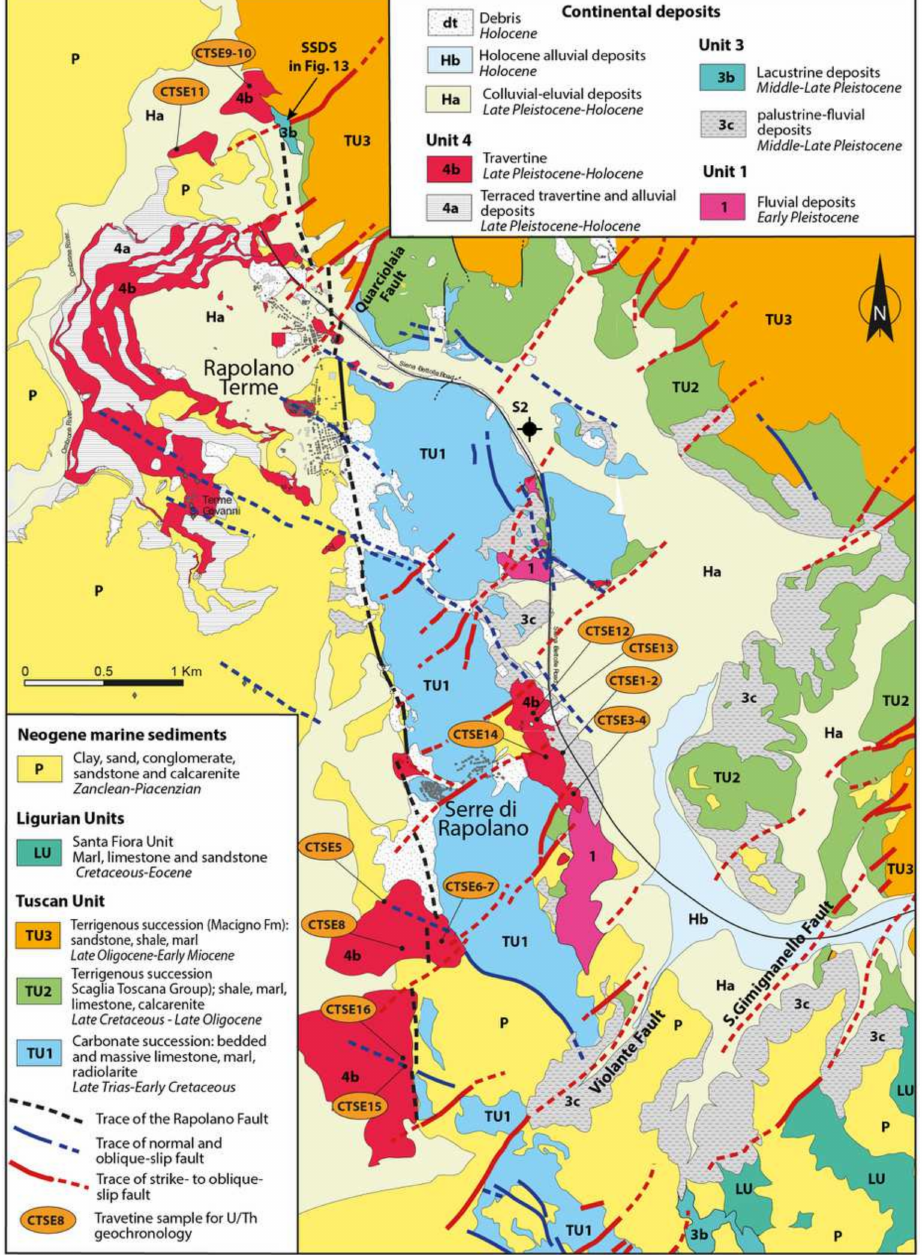
Figure 5. Geological map of the Sentino Basin (after [58], improved and expanded toward south). Querciolaia Fault corresponds to the F2 mentioned in the text and indicated in Figure 2; Violante and San Gimignanello Faults correspond to the F3 mentioned in the text and indicated in Figure